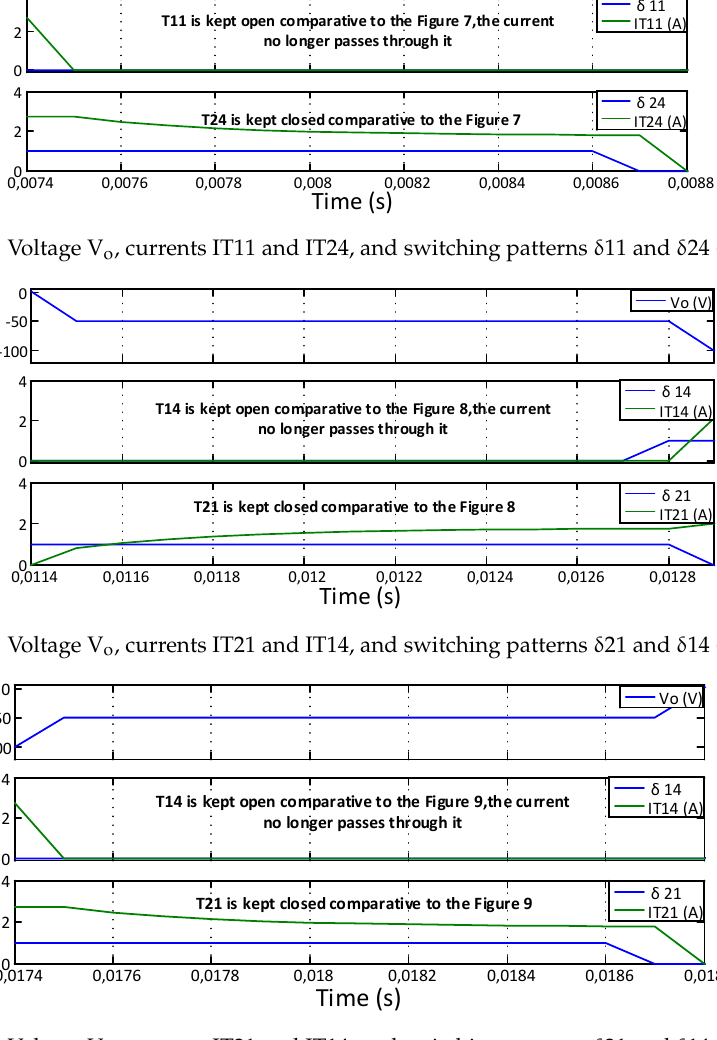
Figure 18. Voltage V o , currents IT21 and IT14, and switching patterns δ 21 and δ 14 (Zoom 4).